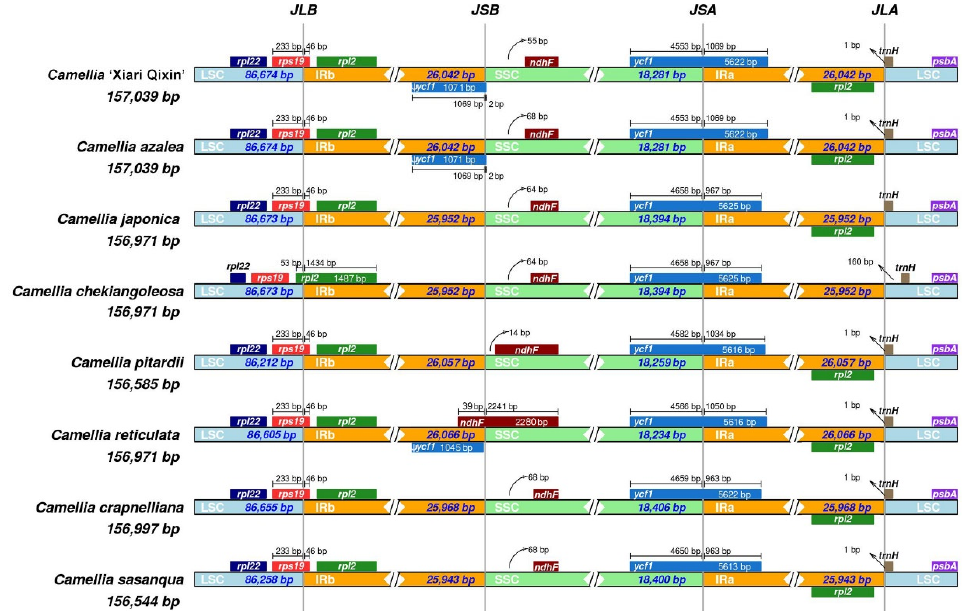
Figure 5. Comparison of structure borders among eight chloroplast genomes from C . ‘Xiari Qixin’ and seven Camellia species. JLB (IRB/LSC), JSB (IRB/SSC), JSA (SSC/IRA), and JLA (IRA/LSC) represent the junction between each corresponding two regions on the genome; genes transcribed by the positive strand are shown on top of line whereas genes that are transcribed by the negative strand are shown on below line.